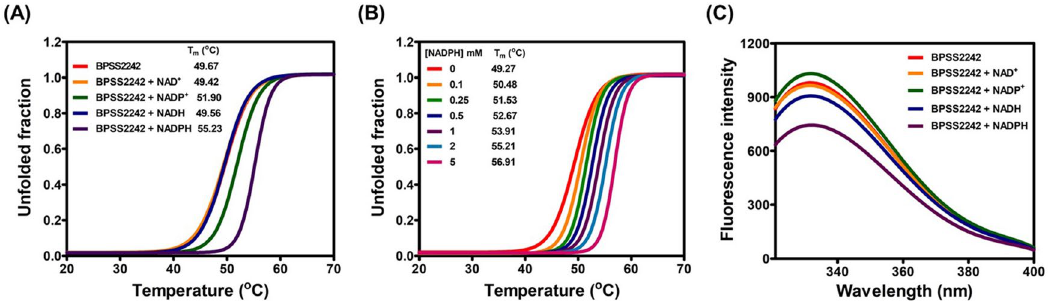
Figure 4. Cofactor preference of BPSS2242. ( A ) Thermal shift assays for screening cofactor preference. ( B ) Effects of NADPH concentration on thermal stability of BPSS2242. ( C ) Intrinsic fluorescence analysis for cofactor binding